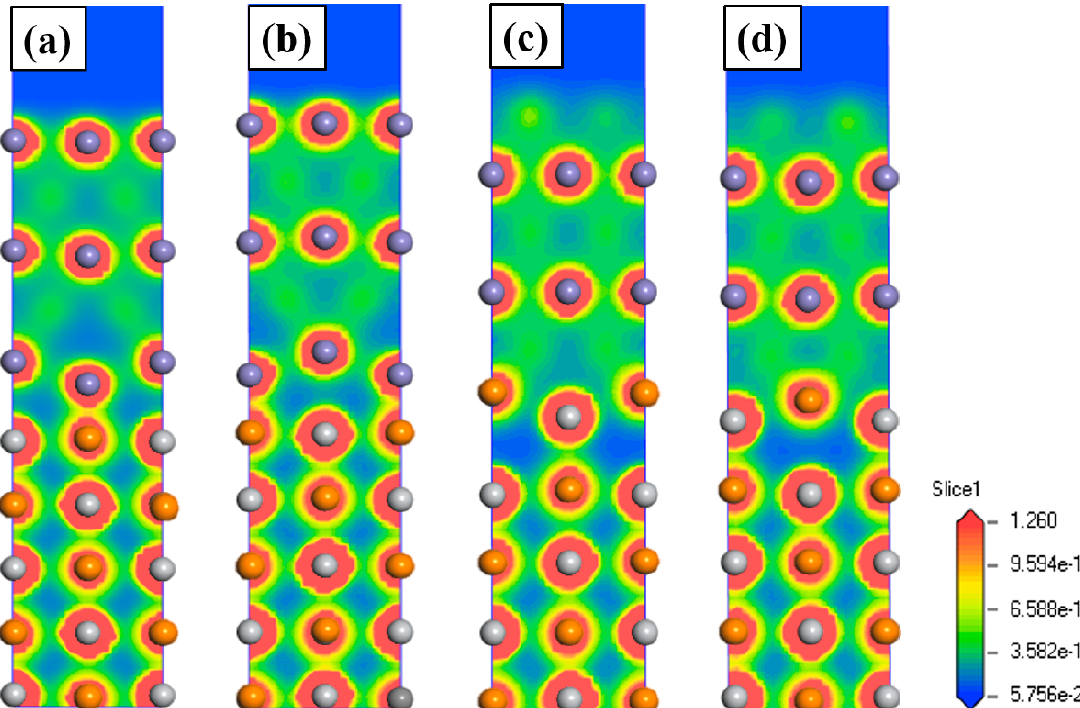
Figure 4. Charge density distributions for the TiC (001) / γ -Fe (001) interfaces: ( a ) Fe-on-C centre; ( b ) Fe-on-Ti centre; ( c ) Fe-bridge-C centre, and ( d ) Fe-bridge-Ti centre.